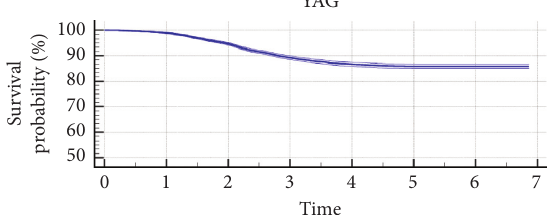
Figure 4: Kaplan–Meier survival curve with its confidence interval concerning transparent posterior capsule survival after cataract surgery (log-rank test: p < 0 . 01) for the sample of eyes evaluated with a follow-up of 7 years or below. Mean survival time was 6.22 years for a 7-year follow-up, and mean survival rate was